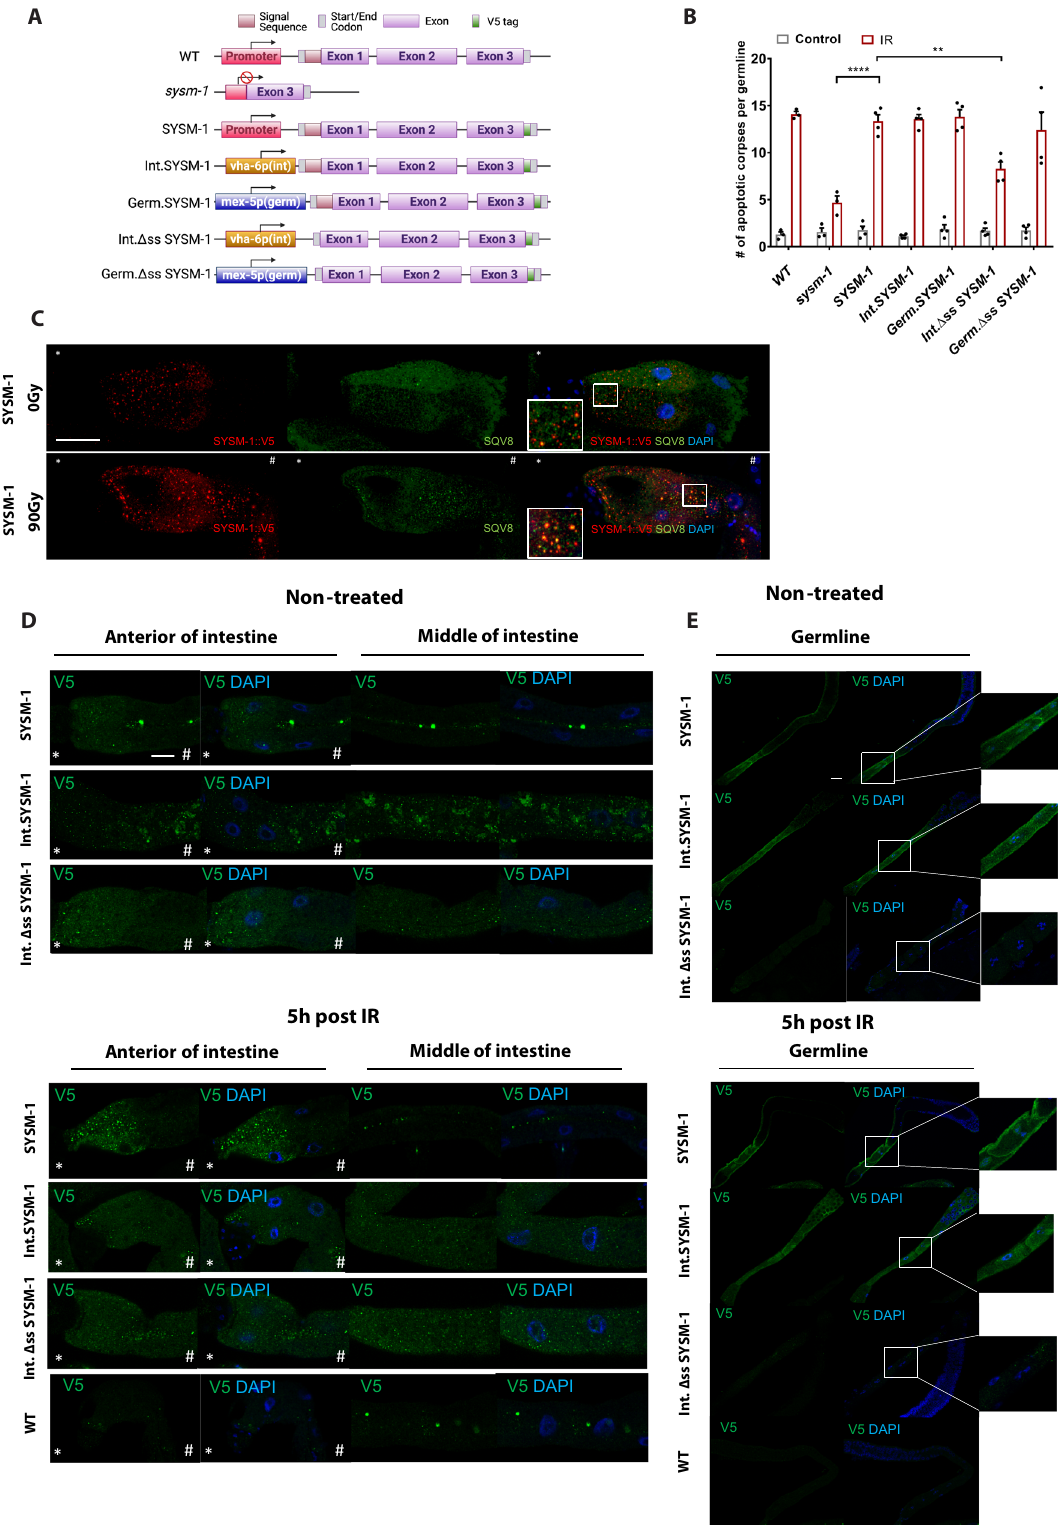
DNA damage-induced apoptosis in meiotic pachytene cells 43